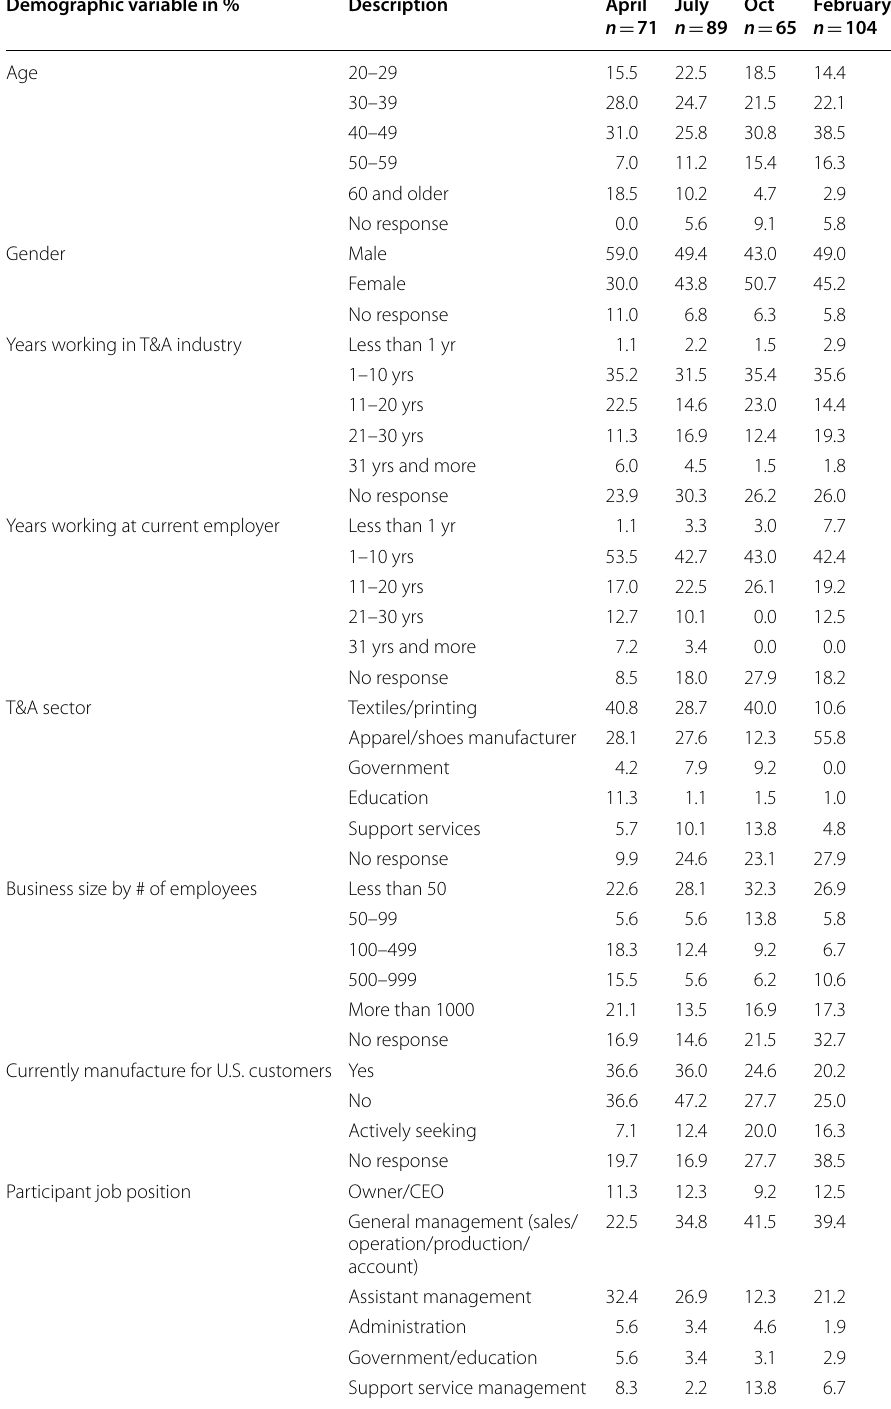
Table 1 Demographic description of workshop